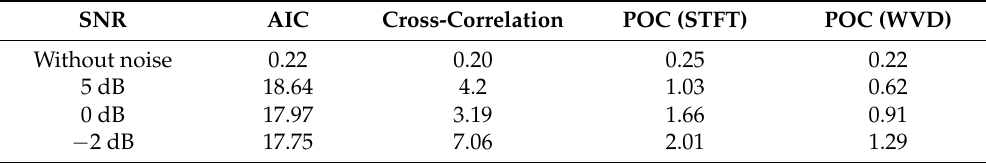
Table 9. The standard deviations of the relative arrival time of the microseismic event under different signal-to-noise ratios, while one abnormal trace exists in the